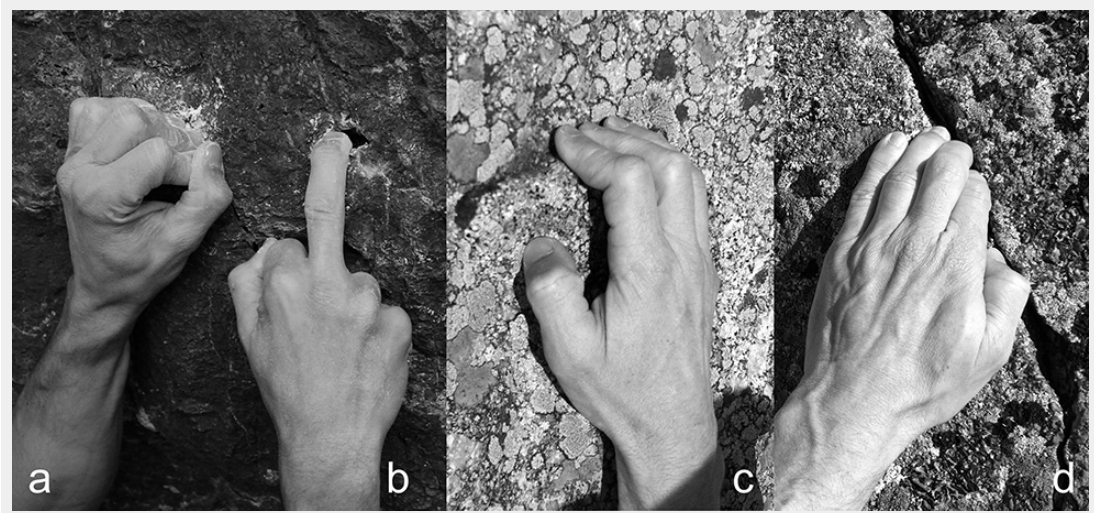
Typical full crimp grip position (A) to hold a small ledge. The PIP joints are flexed more than 90° and the DIP joints are hyper-extended, this way the thumb can also act as a holding force. One finger pocket (B) with typically completely flexed adjacent fingers increases flexion force of a single finger to up to 50%. The half/open crimp position (C) with PIP joints flexed to about 80° thereby generating most flexion torque. Squeezing and distorting the fingertips into a crack (D) is sometimes the only way to hold on.